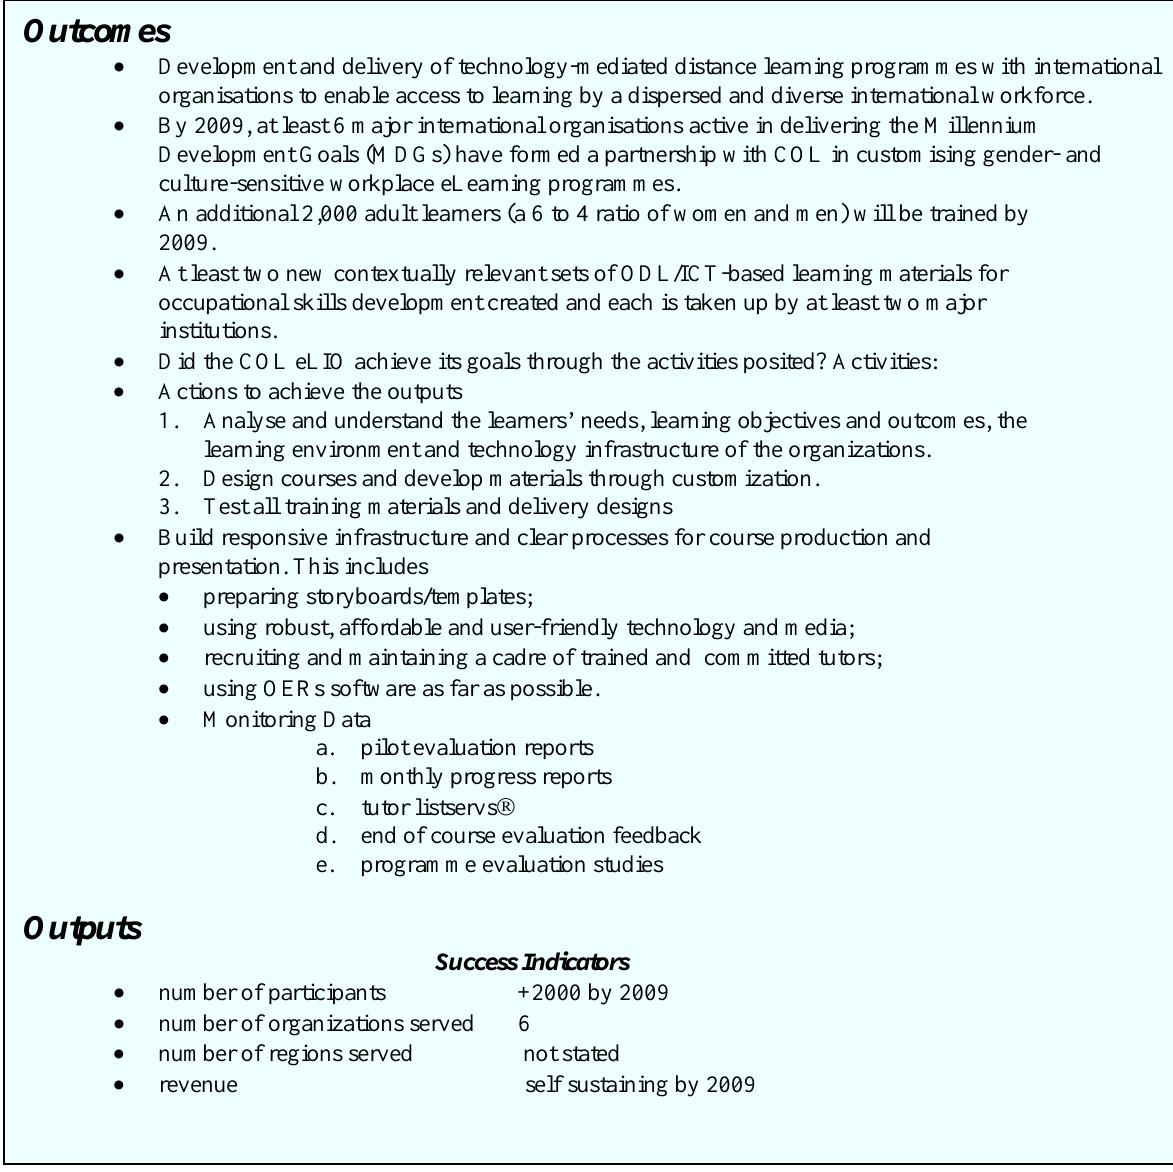
Planned Outcomes and Outputs